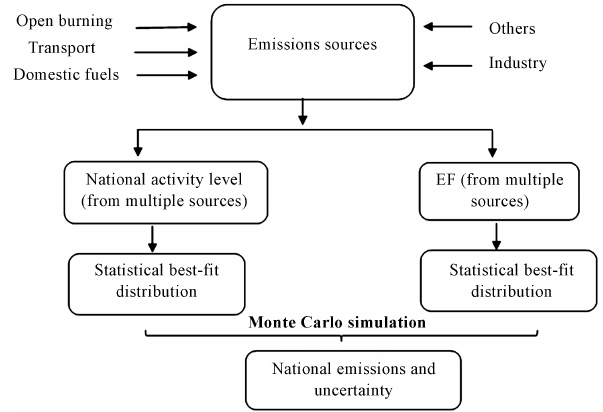
Figure 1. Methodology for national